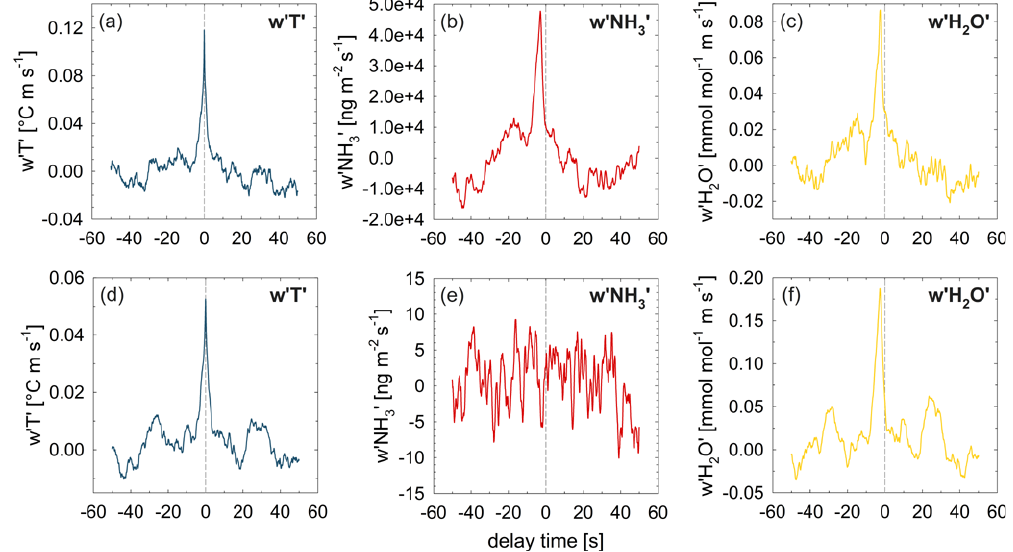
Fig. 6. Two examples of a set of covariances as a function of time shift between the scalar time series and vertical wind time series: